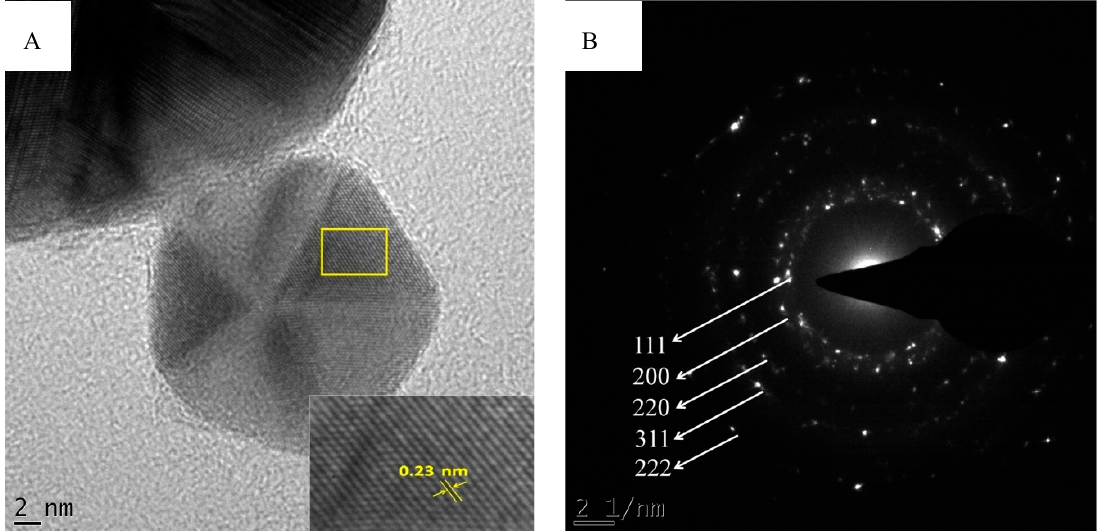
Figure 4. TEM images of A. linearis (rooibos tea) AuNPs showing ( A ) decahedron nanocrystal demonstrating the lattice fringes with spacing of 0.23 nm; ( B ) selected electron diffraction (SAED) pattern.